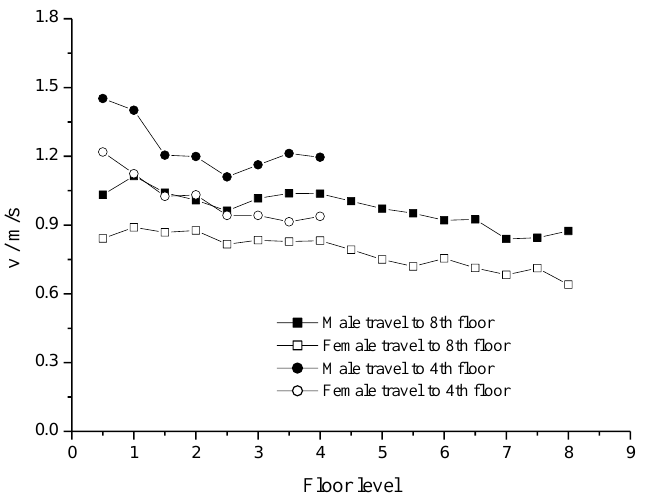
Figure 10. Comparison of the mean ascending speed of traveling 8 floors and 4 floors.